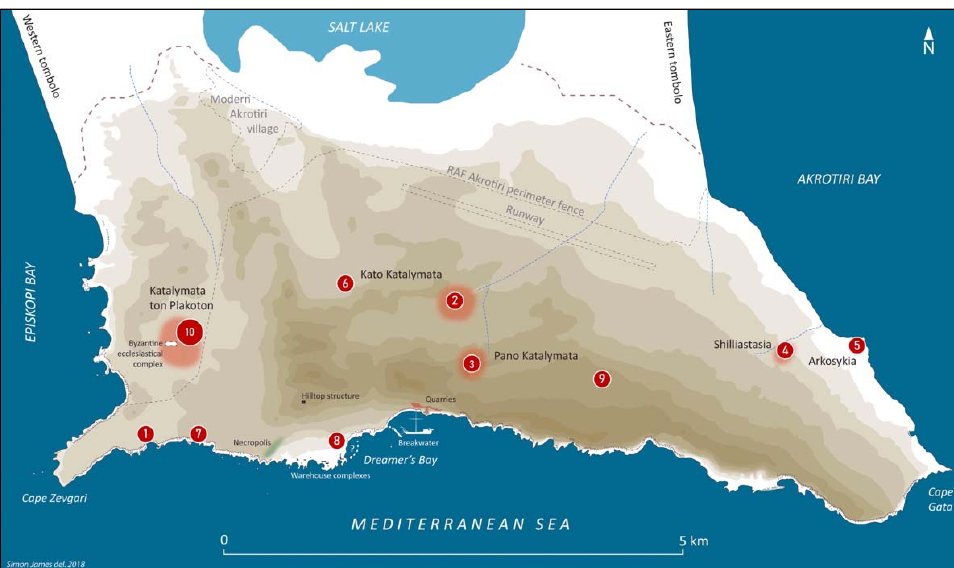
Figure 2. Late Antique sites on the Akrotiri peninsula. 1: Agia Iphigenia; 2: Kato Katalymmata; 3: Pano Katalymmata; 4: Shillastasia; 5: Arkosykia; 6: Agios Markos; 7: Agios Sylas cave; 8: Dreamer’s Bay; 9: Lania cave basilicas, 10: Katalymmata ton Plakoton (Adapted from James et al. 2021, p.